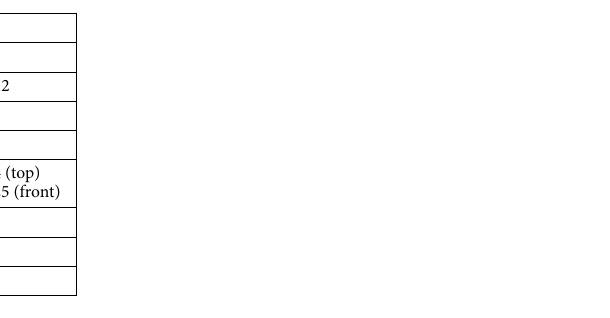
Table 1. Experimental conditions for the 4D PTV